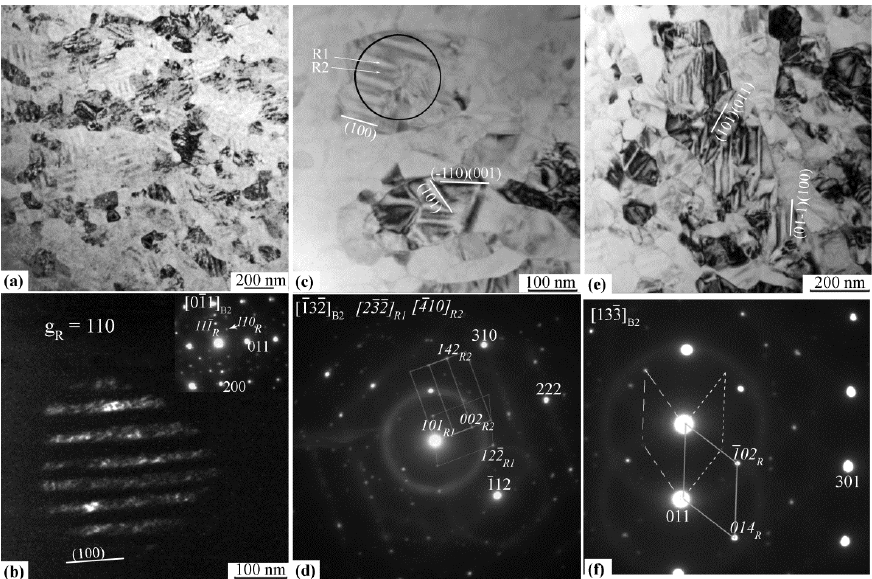
Figure 7. Structure of samples after one loading-unloading cycle, pre-annealed at 300 °C ( a , b ) and 400 °C ( c – f ): ( a ) BF of a nanograin region, ( b ) DF of R phase plate and corresponding SAED (Ds = 180 nm), Z B2 = [0 1̅ 1] and one of the three variants of R phase present on the SAED with Z R = [ 1̅ 10] are indexed; ( c ) BF and ( d ) SAED from area in the circle on ( c ), R1- and R2- reciprocal lattice section correspond to plates R1 and R2 in Figure ( c ); ( e ) BF and ( f ) SAED (Ds = 180 nm), Z B2 = [13 3̅ ] and Z R = [2 4̅ 1] (solid line) are indexed, the dash lines highlight the lattices of two R phase variants in a twins ratio with Z R = <201>.